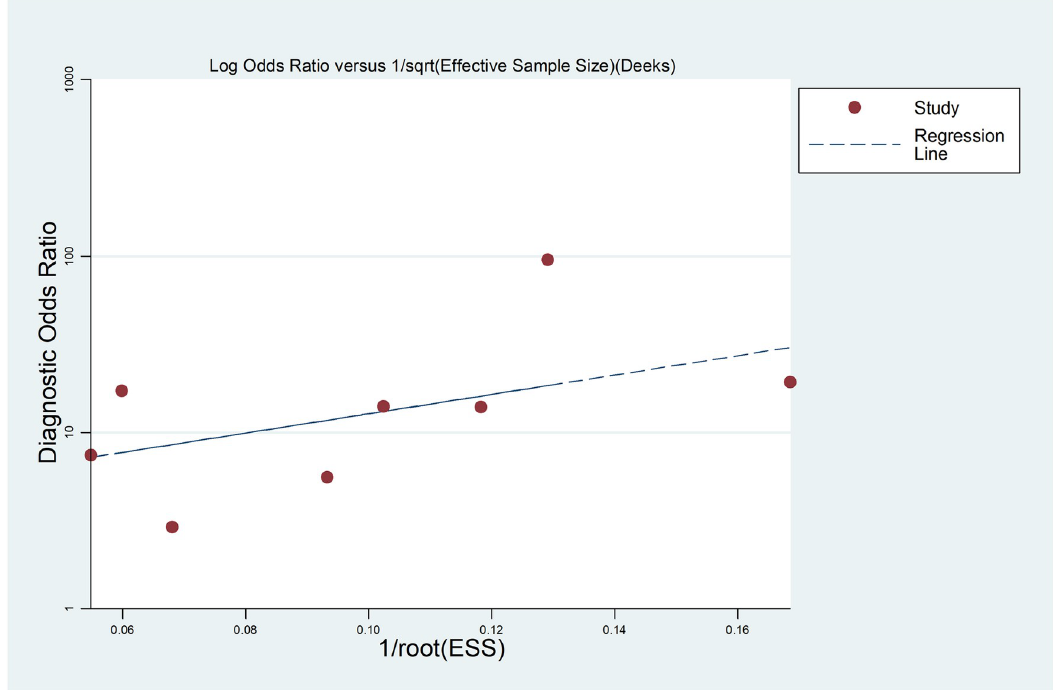
Fig 10. Deeks’ funnel plot for testing publication bias.